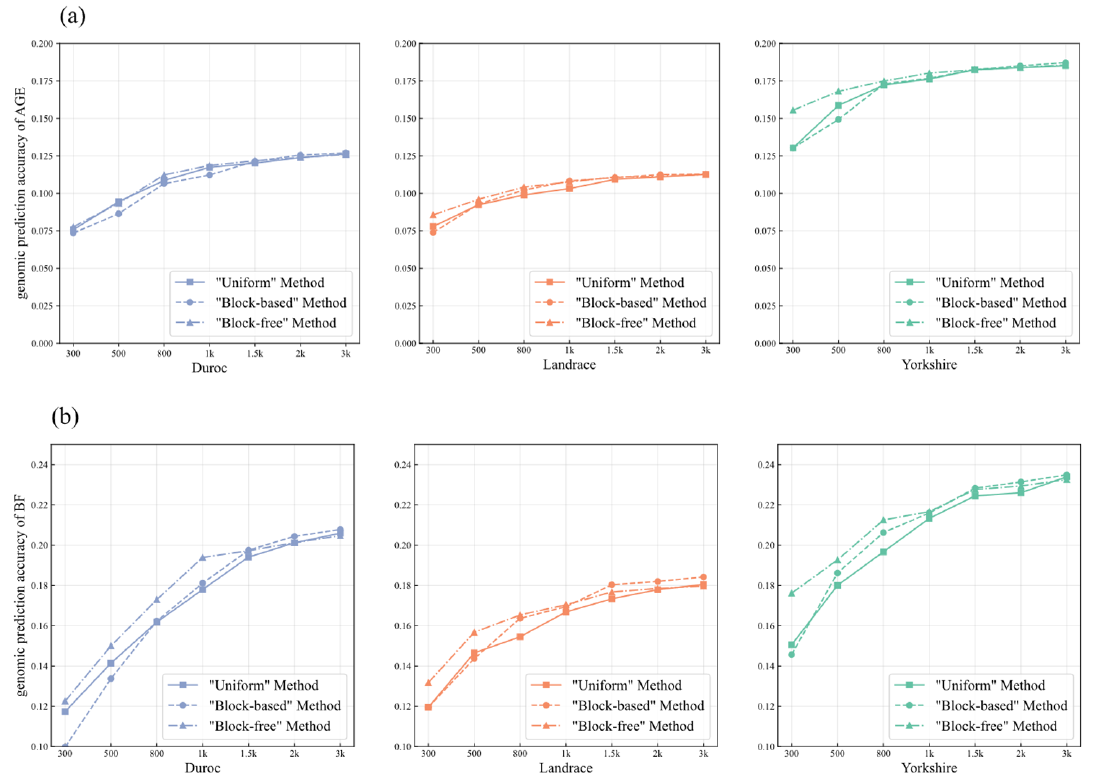
Figure 4. GEBV prediction accuracies of different low-density panels. The horizontal coordinate represents the density of low-density panels, and the vertical coordinate indicates ( a ) accuracies of GEBVs prediction of AGE calculated by imputed panels, and ( b ) accuracies of GEBVs prediction of BF calculated by imputed panels, respectively. The shapes of square, circle, and triangle represent the “uniform” method, the “block-based” method, and the “block-free” method, respectively. The colors blue, orange, and green represent Duroc, Landrace, and Yorkshire, respectively.